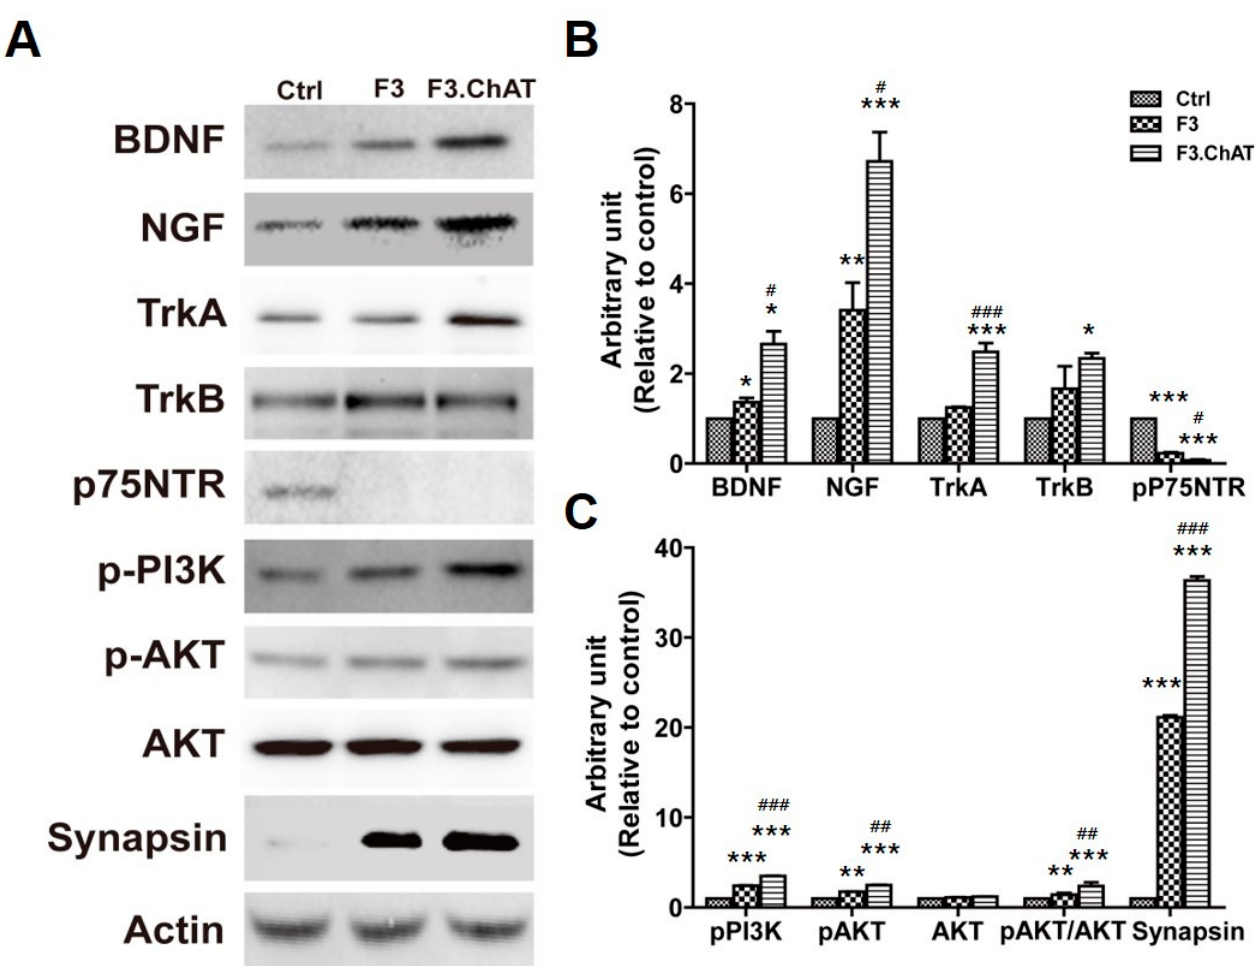
Figure 4. Expression of proteins related to the neurotrophin pathway. ( A ) Representative bands of protein related with the neurotrophin pathway. ( B , C ) The band densities were normalized to that of actin. * Significantly different from the normal control ( p < 0.05). ** Significantly different from the normal control ( p < 0.005). *** Significantly different from the normal control ( p < 0.001). # Significantly different from the F3 ( p < 0.05). ## Significantly different from the F3 ( p < 0.005). ### Significantly different from the F3 ( p < 0.001) .